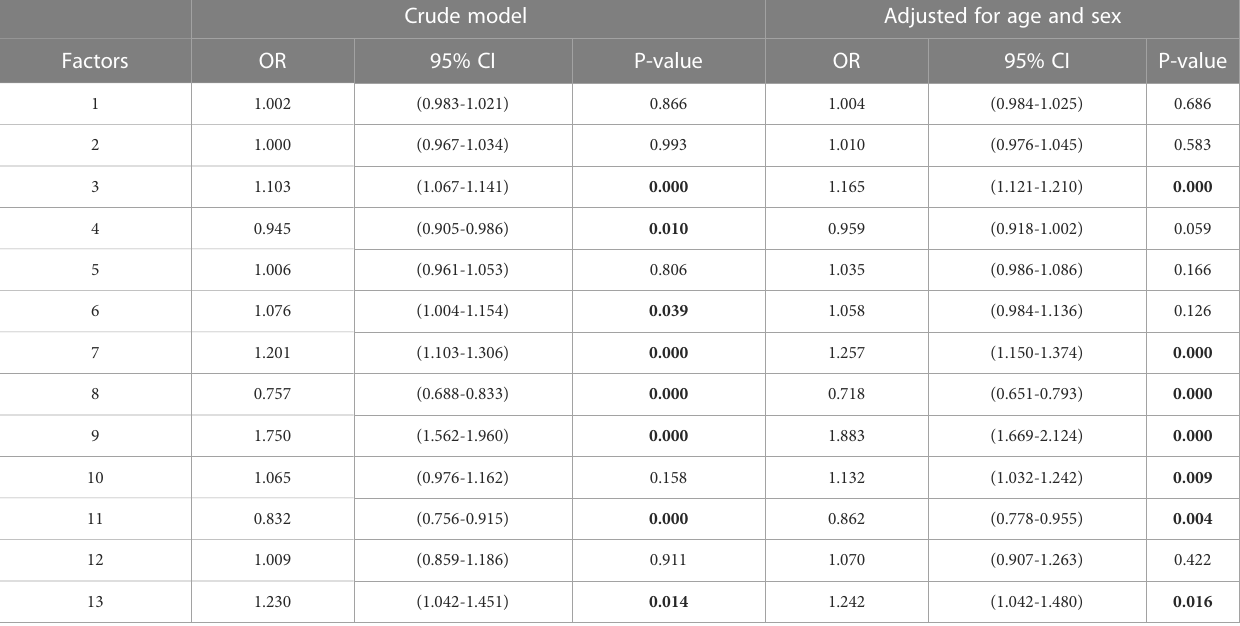
TABLE 4 The unadjusted and adjusted odds ratio (OR) for the association between metabolites with VIP score values above 1.0 and metabolic syndrome (MetS). Crude model Adjusted for age and